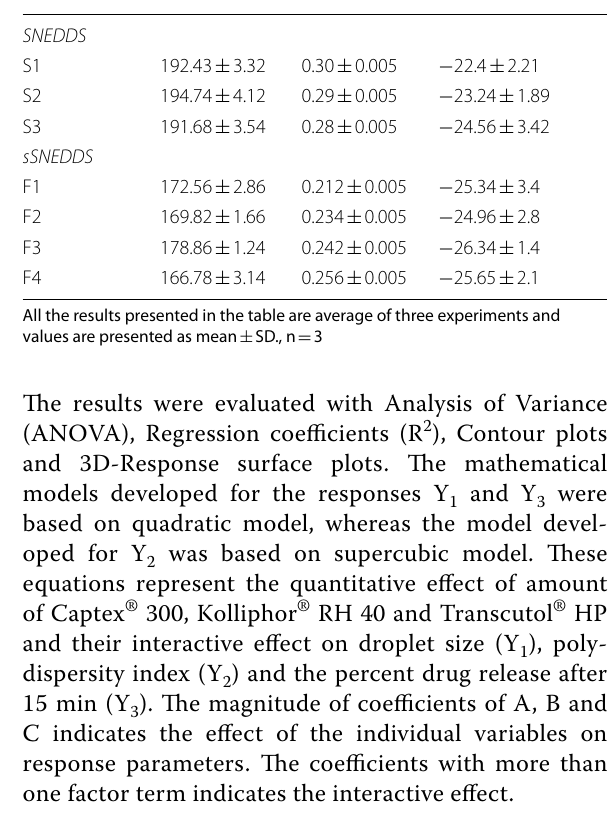
Table 5 Results of droplet size, PDI and zeta potential